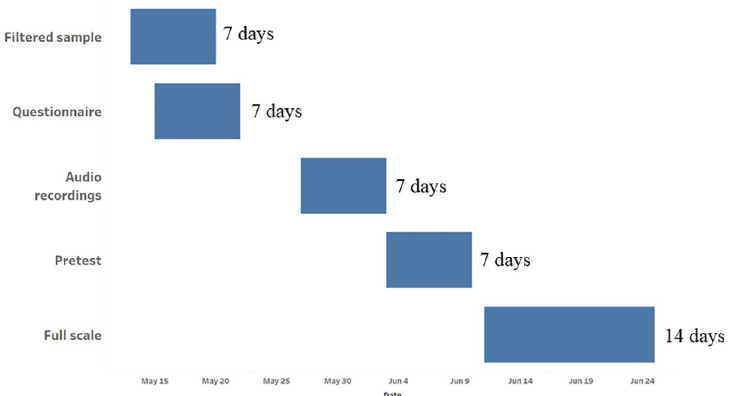
Fig 1. Ecuador planning and data collection